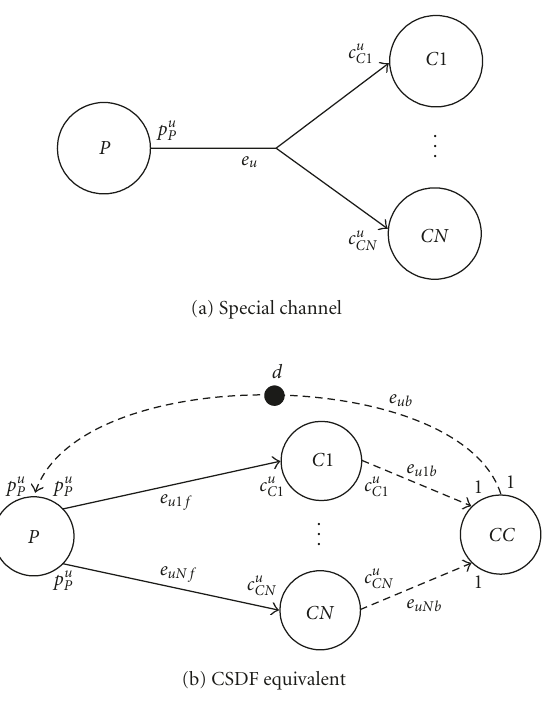
Figure 5: Multiple consumers on an edge between a producer P with period L P and sequence p = { p u P (0), ... , p u P ( L P − 1) } and N consumers C 1, ··· , CN with periods L C 1 , ... , L CN and sequences ... , c u L ... , cN = { c u ... , c u L c 1 = { c u C 1 − 1) } , CN − C 1 (0), C 1 ( CN (0), CN ( 1) }